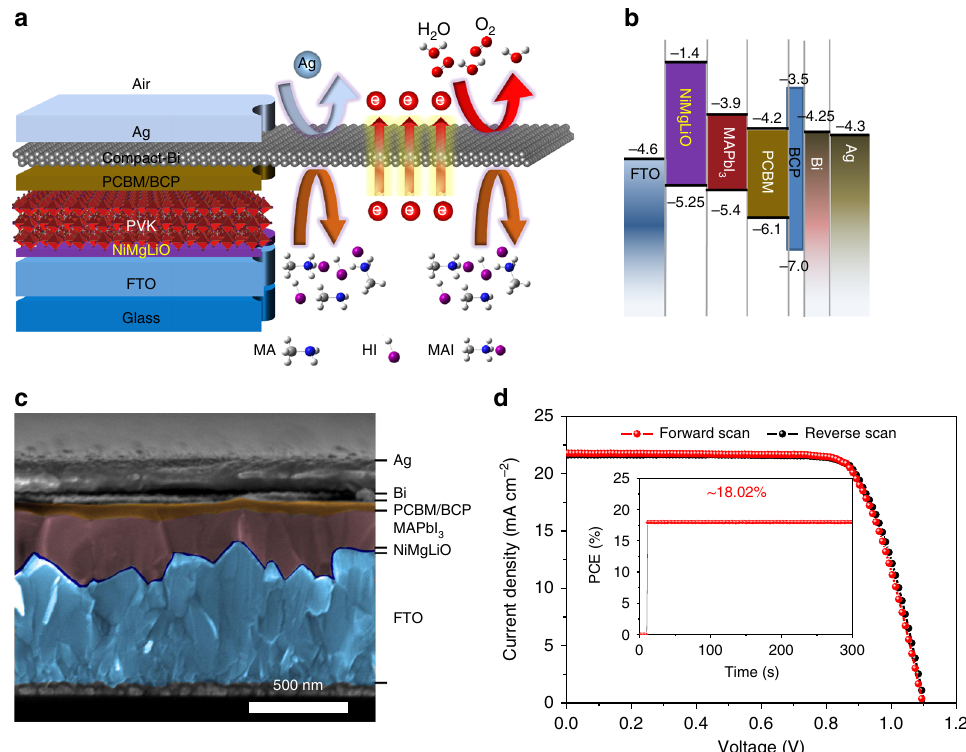
Fig. 3 Structure, energy-level alignment, and performance of HPVKSC. a Schematic diagram of the device structure in this work: FTO/NiMgLiO/PVK/ PCBM/BCP/Bi/Ag; the Bi interlayer has a superior shielding capability, prohibiting both inward and outward permeation. b Energy level diagram and c SEM cross-sectional image of the device (scale bar: 500 nm). d J – V curves of a typical large-area (1 cm 2 ) HPVKSC with a 20-nm Bi interlayer based on a MAPbI 3 absorber, with the stabilized PCE measured at 0.872 V as the inset. Source data are provided as a Source Data fi curves of MA-HPVKSCs with an optimized Bi interlayer (20 nm thick). Under AM 1.5G simulated sunlight (100 mW cm − 2 ), the